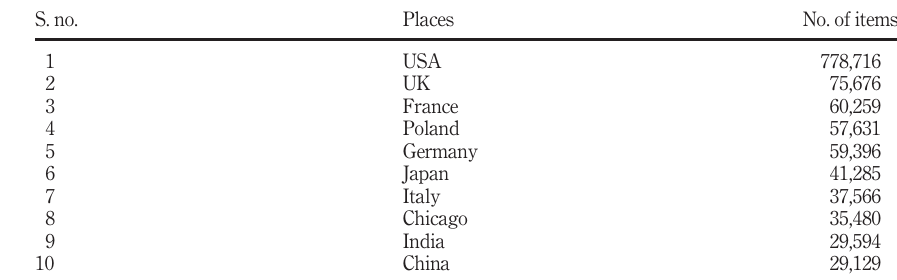
Google Art and Culture